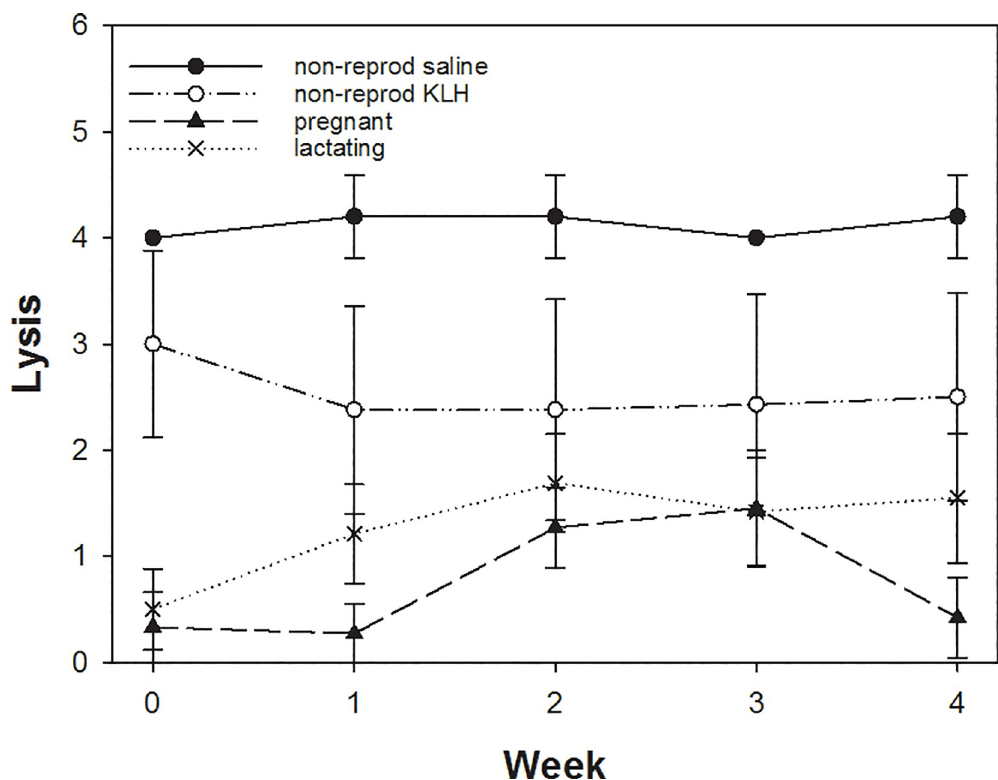
Fig 4. Differences in haemolysis titers across the 4 weeks for non-reproducing, pregnant and lactating females. Plotted are means and SE. For details see text.